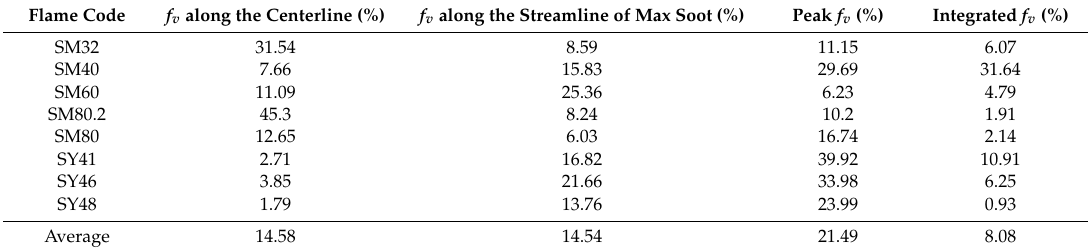
Table 3. Relative errors between the CFD and the predicted data by ANN for eight flames used to train the